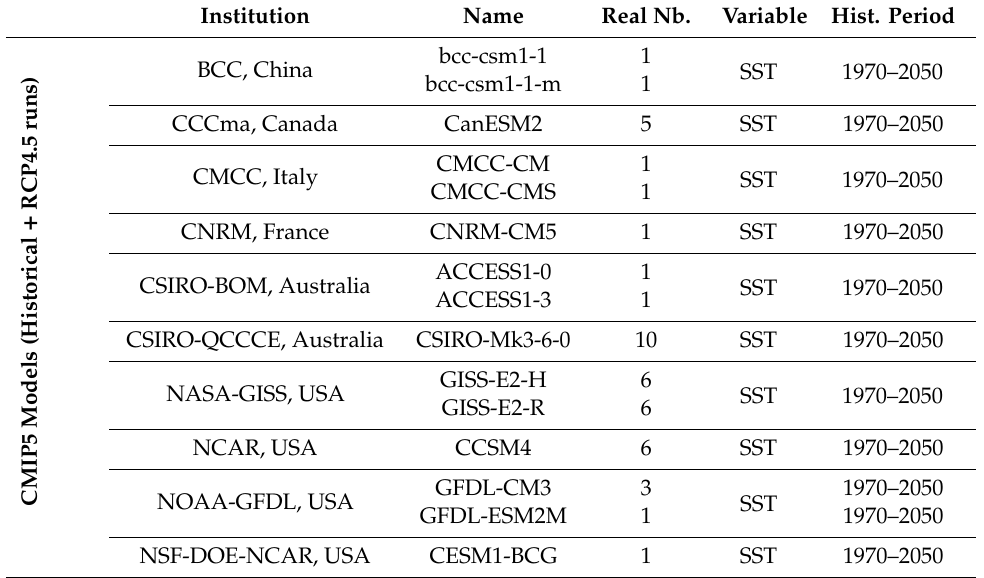
Table 2. Summarized information on CMIP5 models used in the